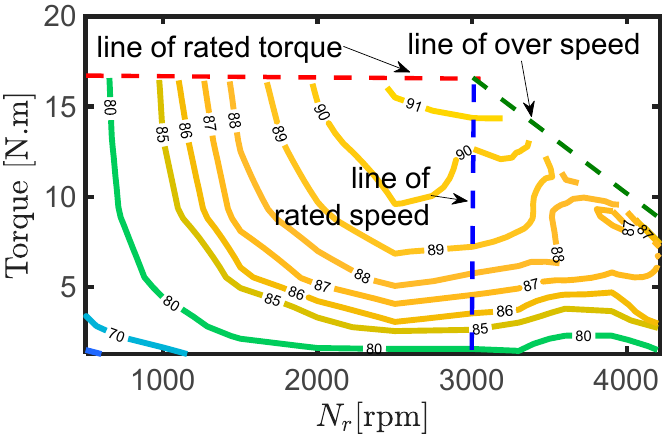
Figure 17. ( a ) Efficiency, ( b ) SynRM total losses at different line currents, optimal current angle, and at rated speed.